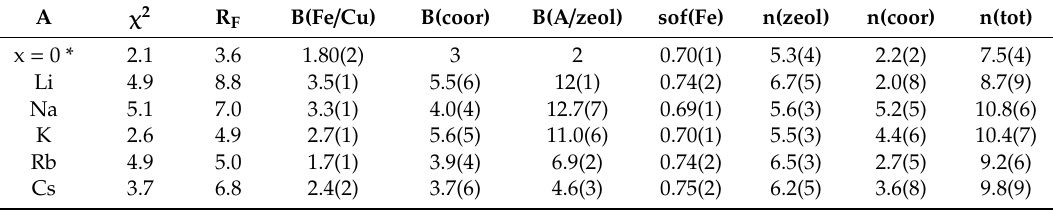
Refinement and structural parameters for A 2 / 3 Cu[Fe(CN) 6 ] 2 / 3 ; B (Fe / Cu) =